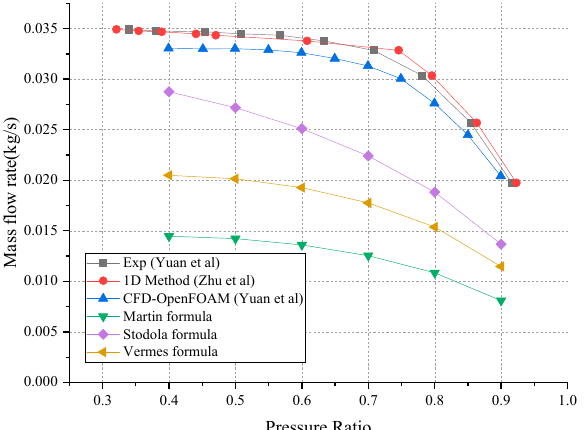
Figure 17. The comparison of SCO 2 see-through labyrinth seal performance curve (based on di ff erent methods).